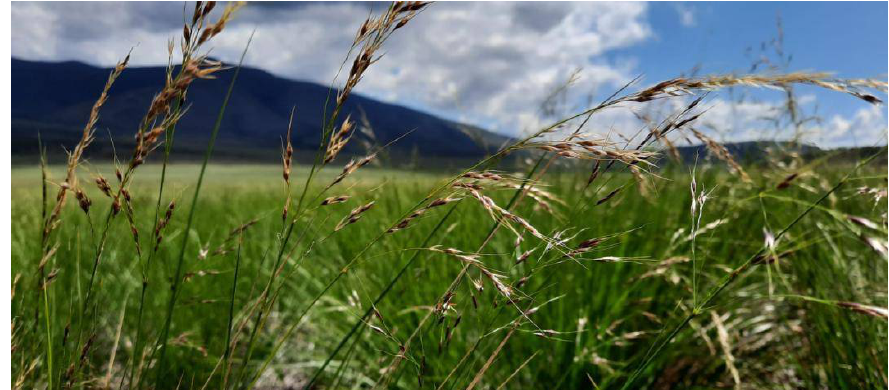
Figure 2. Inflorescence Amelichloa clandestina in the study